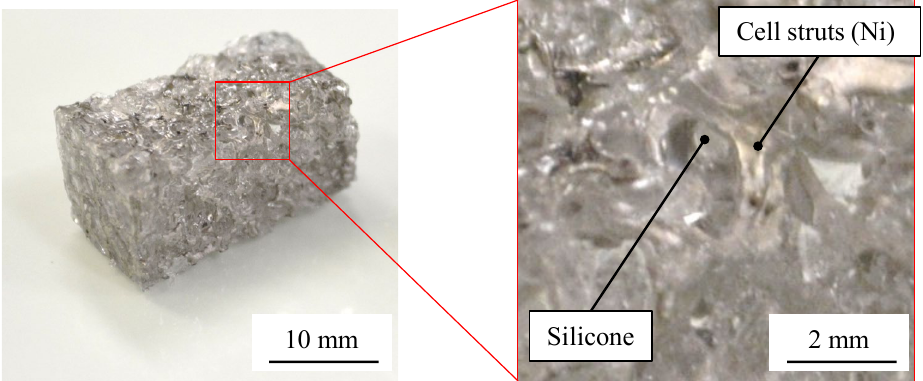
Figure 3. External and enlarged view of Ni/silicone foam.